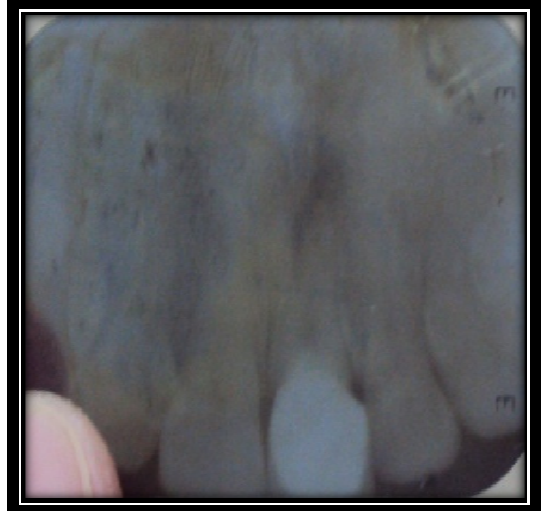
apical radiograph for maxillary left central incisor with peri